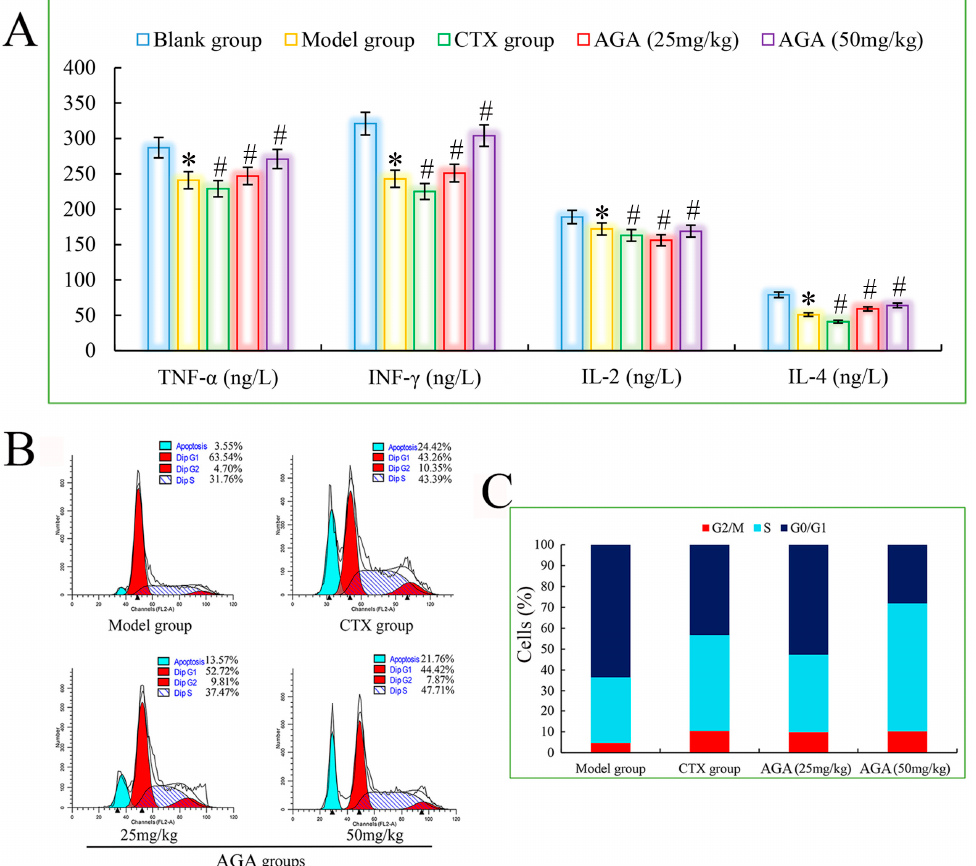
Figure 6. The blood cytokines detection of H22 tumor-bearing mice ( A ). Cell cycle phase distribution of H22 tumor-bearing mice, histograms of DNA content in the cells ( B ) and bar graph of cell pro- portion in G0/G1, S and G2/M phases ( C ). * p < 0.05, compared with Blank group; # p < 0.05, compared with Model